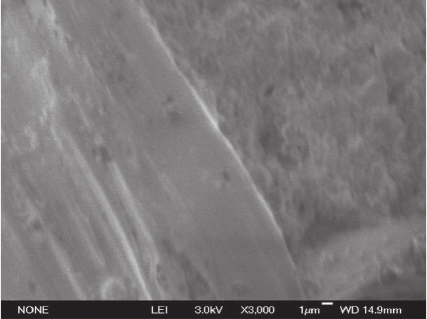
Figure 5: Sectional topography of T91 after deposition corrosion.